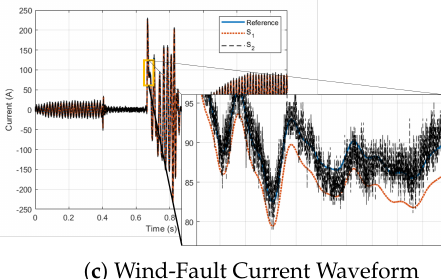
Figure 4. Event Waveforms. The blue (solid) curves indicate the reference waveforms, whereas the red (dotted) and black (dashed) curves indicate the responses from sensors S 1 and S 2 ,